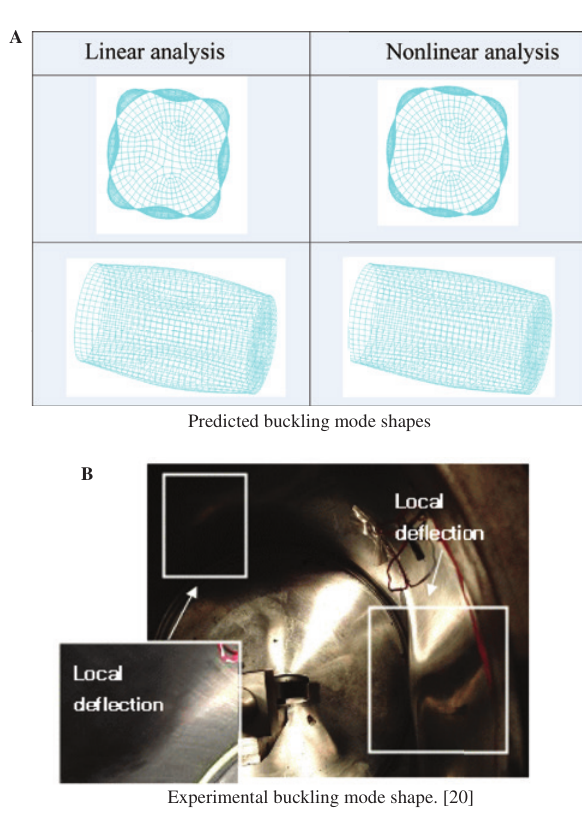
Figure 4: Buckling mode shape for the composite cylinder (CTM3). (A) Predicted buckling mode shapes. (B) Experimental buckling mode shape [20].